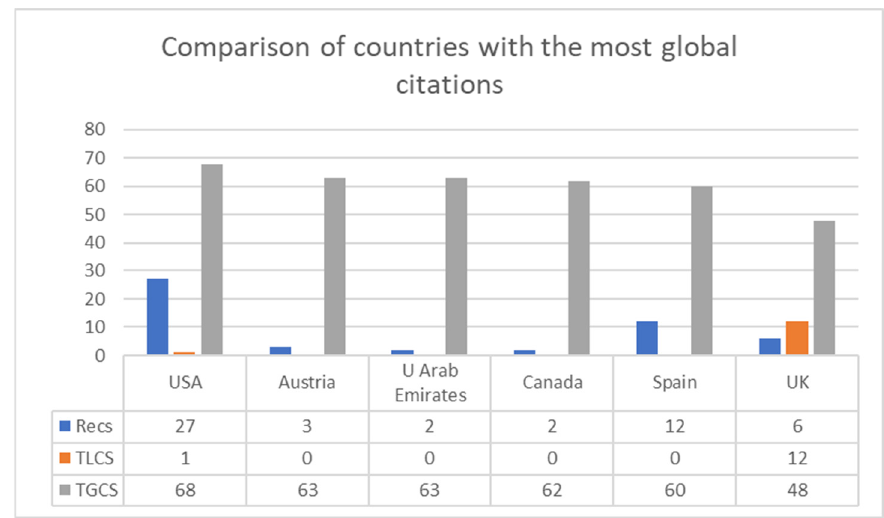
Figure 5. Number of articles published by country ( ≥ 1 article).